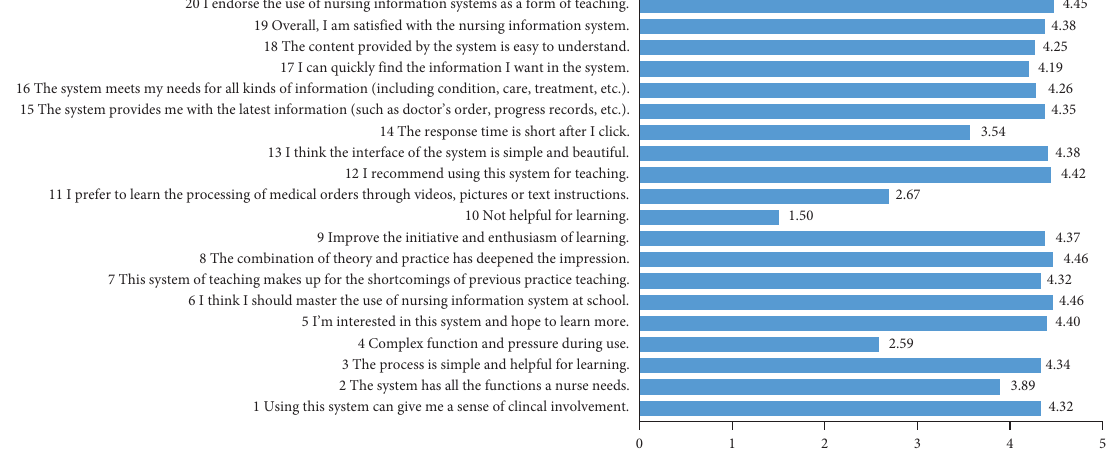
Figure 2: Strongly disagree � 1, disagree � 2, neutra1 � 3, agree � 4, strongly agree � 5. Table 1: Scale scores of the diferent year classes ( N �